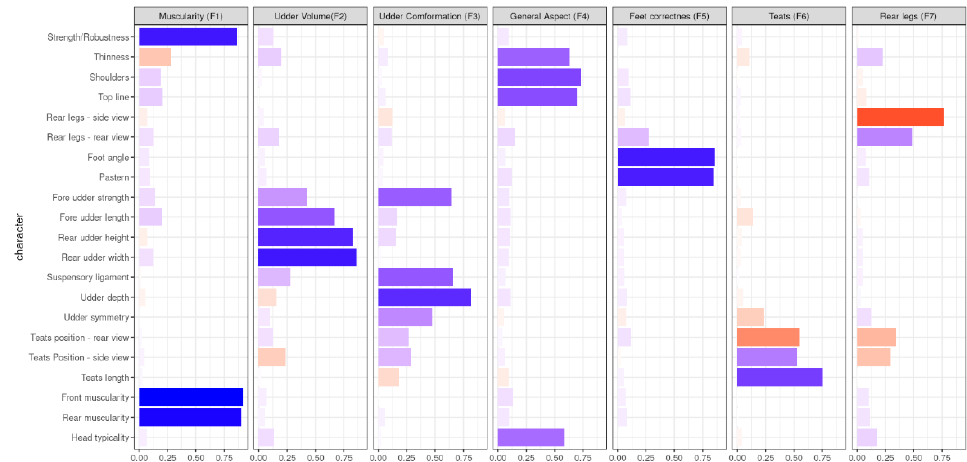
Figure 1. Loading coefficient (LC) of individual morphological traits within the seven latent factors extracted from the factor analysis (i.e., with eigenvalue > 1) after the varimax rotation. Only LC ≤ − 0.45 or ≥ 0.45 have been reported. Blue bars represent positive loading coefficients, red bars negative loading coefficients.